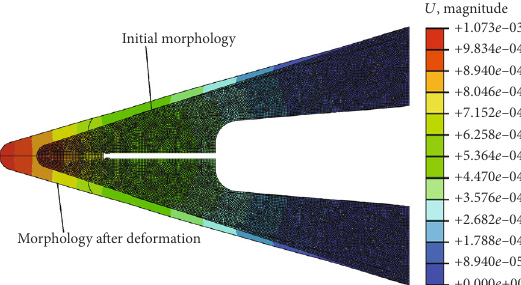
Figure 13: Deformation contour of the nose cap at 100 s.